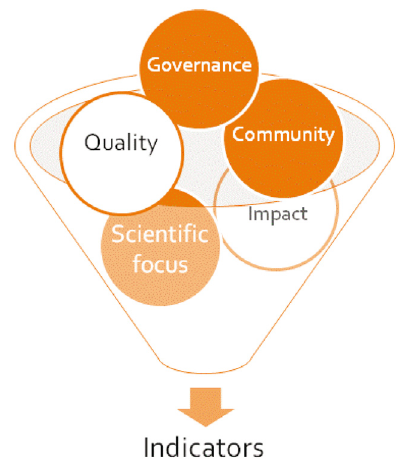
Figure 2. A carefully chosen basket of qualitative and quantitative indicators for bioinformatics